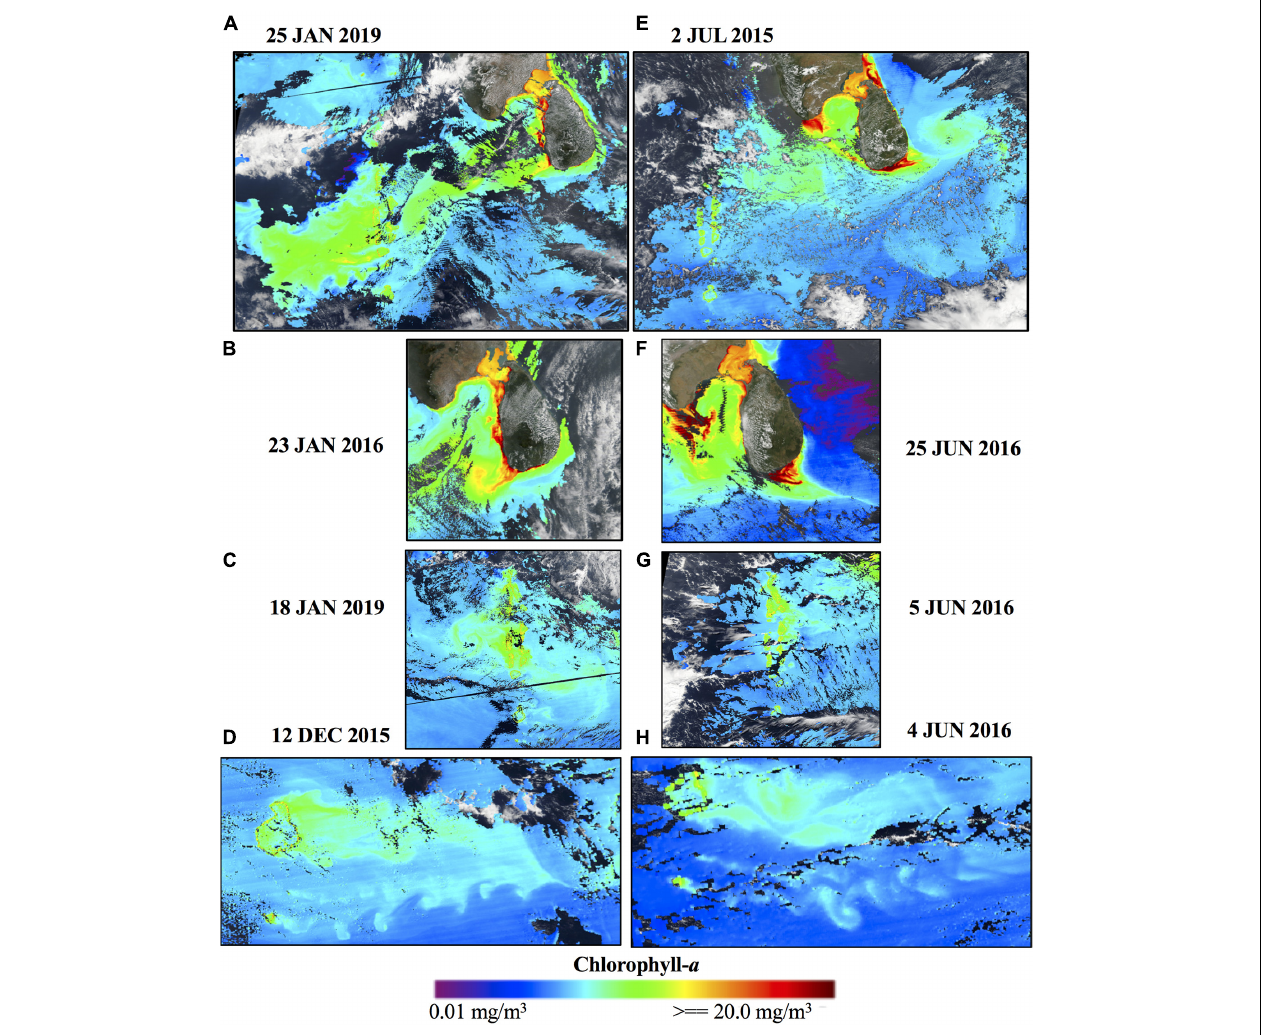
FIGURE 3 | Daily snapshots of surface chlorophyll- a concentrations around Sri Lanka and the Maldives during the (A–D) Northeast Monsoon (Dec–Feb) and the (E–H) Southwest Monsoon (Jun–Aug). (A,E) Highlights potential connectivity based on the high chlorophyll- a concentrations “advected” from Sri Lanka to the Maldives. (B,F) Identifies the location of the IME along the south coast of Sri Lanka during the NEM and SWM, respectively. (C,G) Identifies the directionality of the IME along the Maldives island chain. (D,H) Displays multiple von Karman vortex streets swirling downstream from the Huvadhoo Atoll during both monsoon periods. Images adapted from EOSDIS Worldview